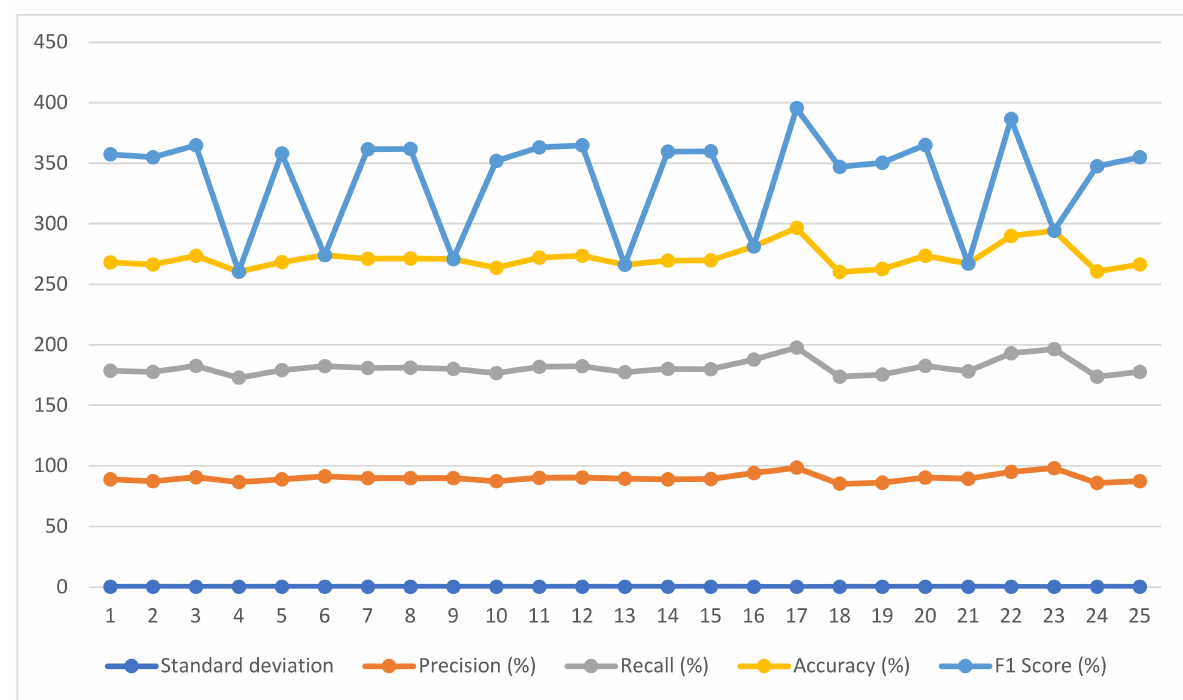
Figure 8. Performance of the proposed algorithms upon